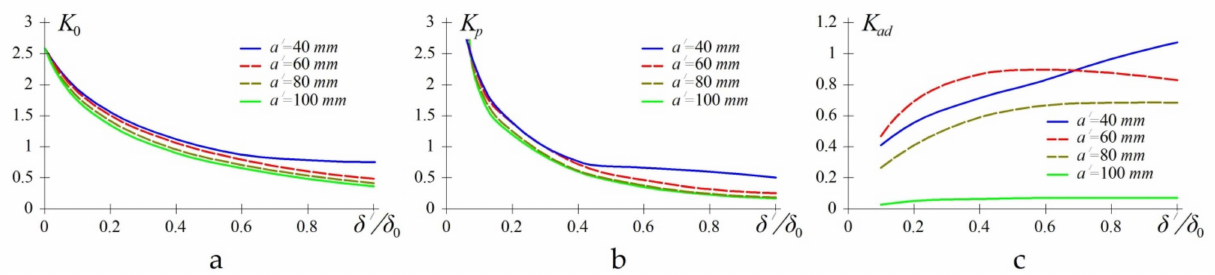
Figure 9. Effect of thickness δ (cid:48) and size of patch a (cid:48) on the loading factor of the repaired panel ( a ) of thickness δ 0 ; loading factor of the patch ( b ) and adhesive interlayer ( c